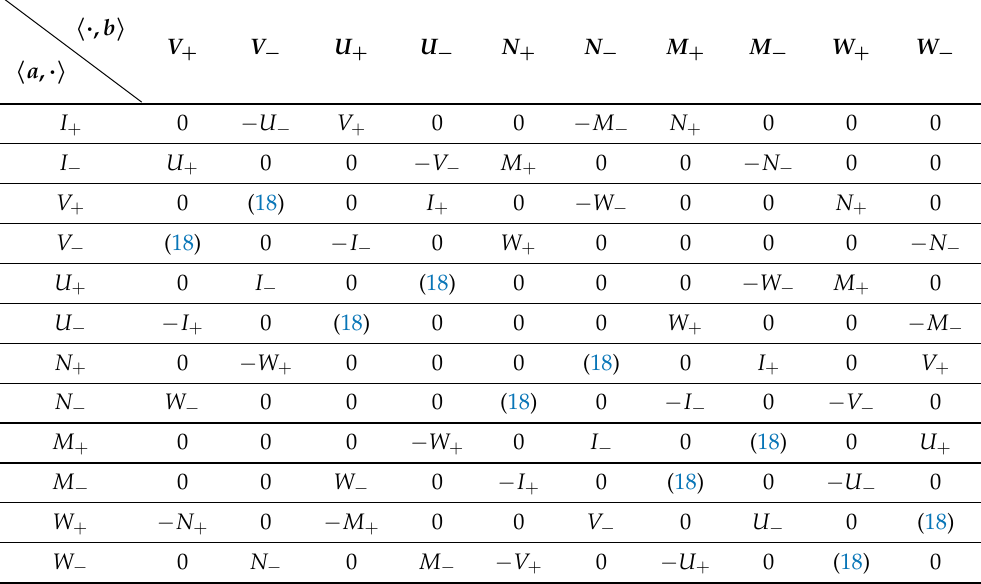
Table 2. Commutators of operators (14),